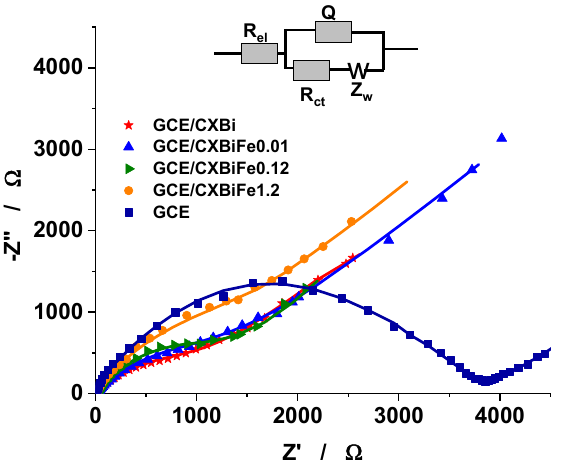
Figure 4. EIS spectra of GCE and GCE/Chi–CXBiFe x . Experimental conditions: supporting elec- trolyte, 0.1 M acetate buffer (pH 4.5) containing 1 mM [Fe(CN)6] 3 − /4 − ; applied potential, 0.2 V vs. Ag/AgCl, KClsat, frequency interval, 0.1–10 4 Hz. Table 3. The parameters of the equivalent